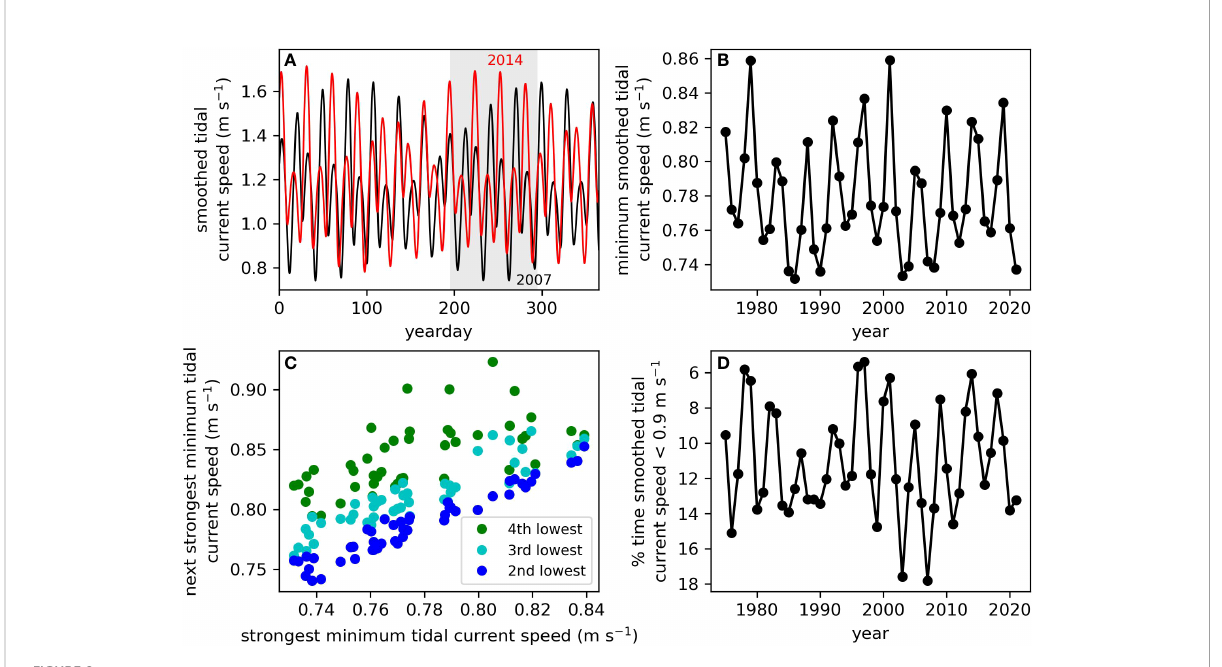
FIGURE 9 Interannual variability in tidal current speed. (A) Predicted smoothed tidal current speeds in 2007 with strong minimums (black) and in 2014 with weak minimums (red). Grey background shows the summer/fall renewal period considered in the rest of the panels. (B) Minimum smoothed tidal current speed predicted during the renewal season in a given year. (C) Correlation between the minimum smoothed tidal current speed during the renewal season in a given year and the 2nd (blue), 3rd (cyan), and 4th (green) lowest events in the same season and year. (D) Percentage of time smoothed tidal current speed is below 0.9 m s -1 during the renewal season in a given year. Note the y-axis is reversed to show the correspondence with the panel